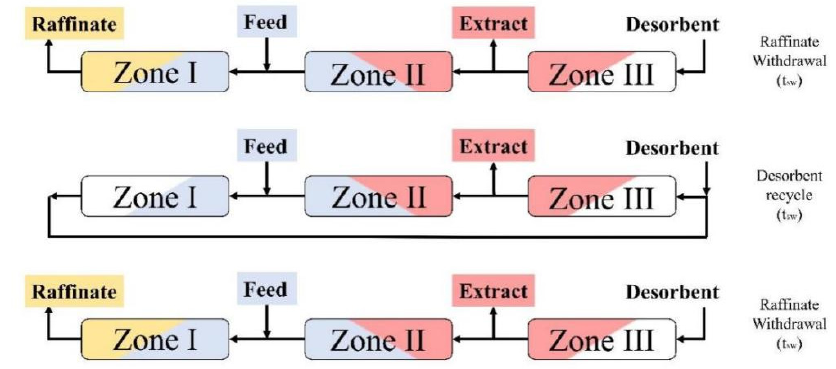
Figure 8. Schematic diagram of the three-zone SMB (“partial withdrawal” operation).